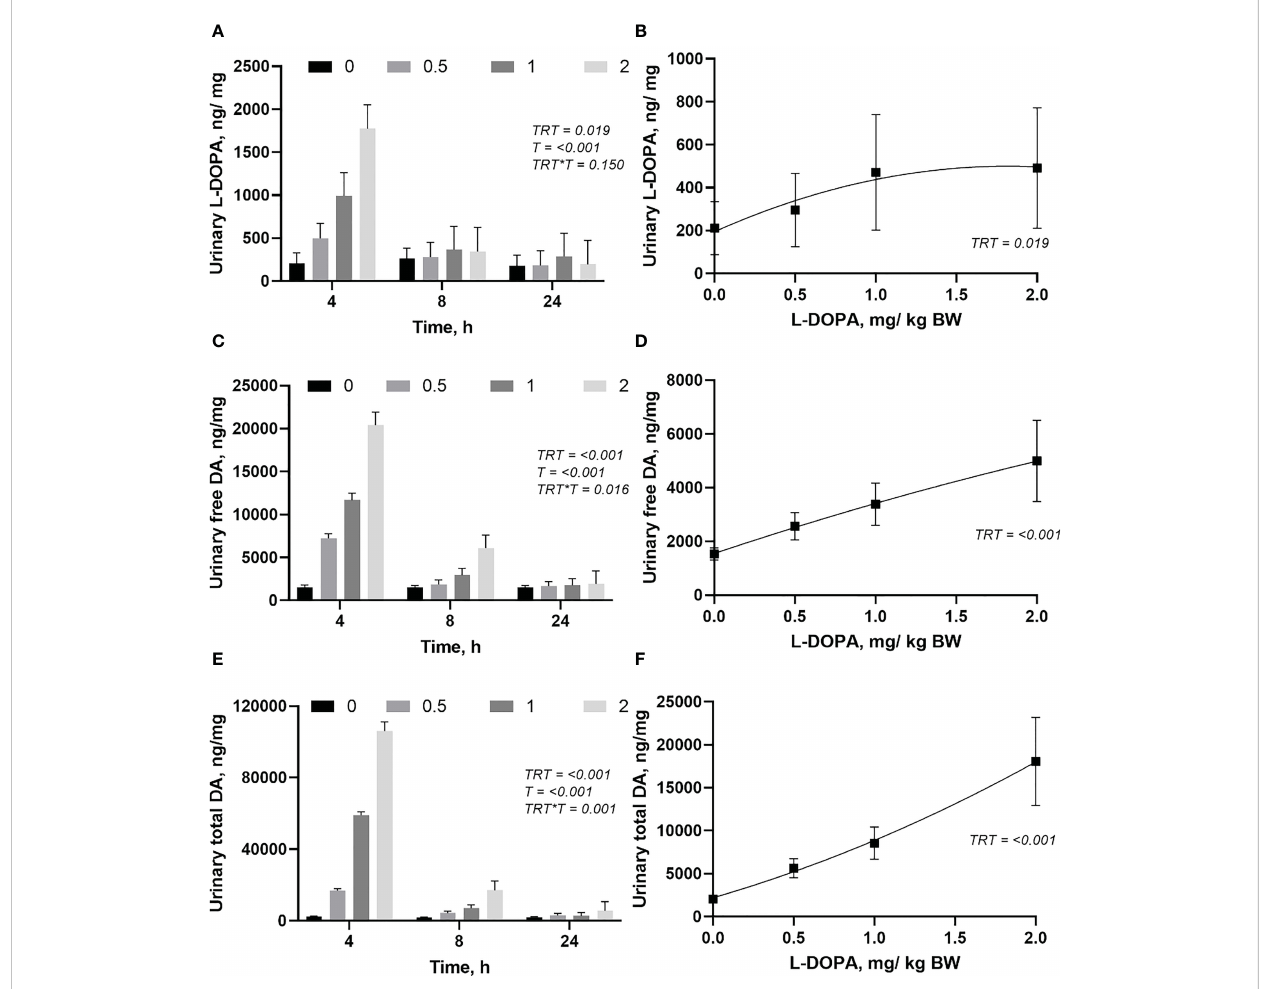
FIGURE 6 Changes in urinary (ng/mg of creatinine) L-DOPA over time (A) and daily (B) , free dopamine (DA) over time (C) and daily (D) , and total DA over time (E) and daily (F) following intra-abomasal infusion of L-DOPA at 0, 0.5, 1 and 2 mg/kg BW. TRT is the effect of treatment, T is the time effect and TRT*T is the interaction. Each value is expressed as the mean ± standard error (n = 8). Urinary creatinine was 6.78, 7.21, 6.82 and 7.01 for the 0, 0.5, 1, and 2 L-DOPA doses,